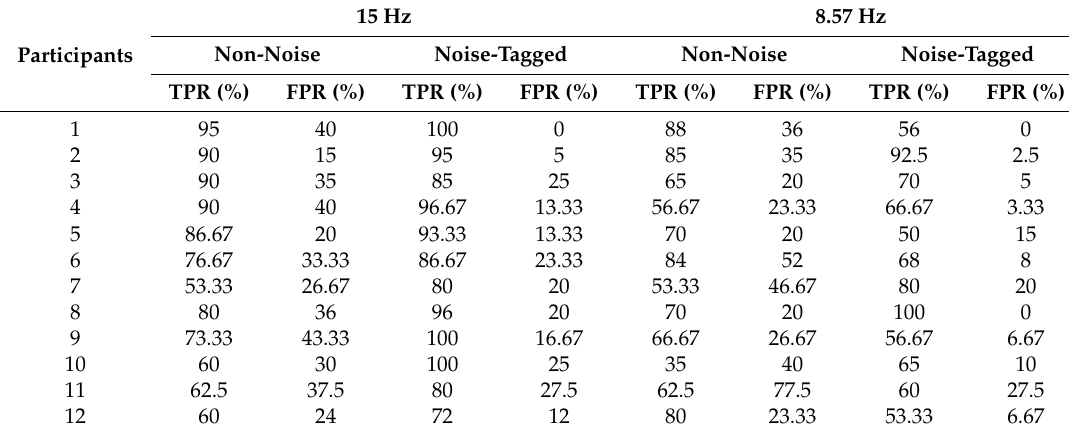
Table 1. The TPR and FPR results of individual